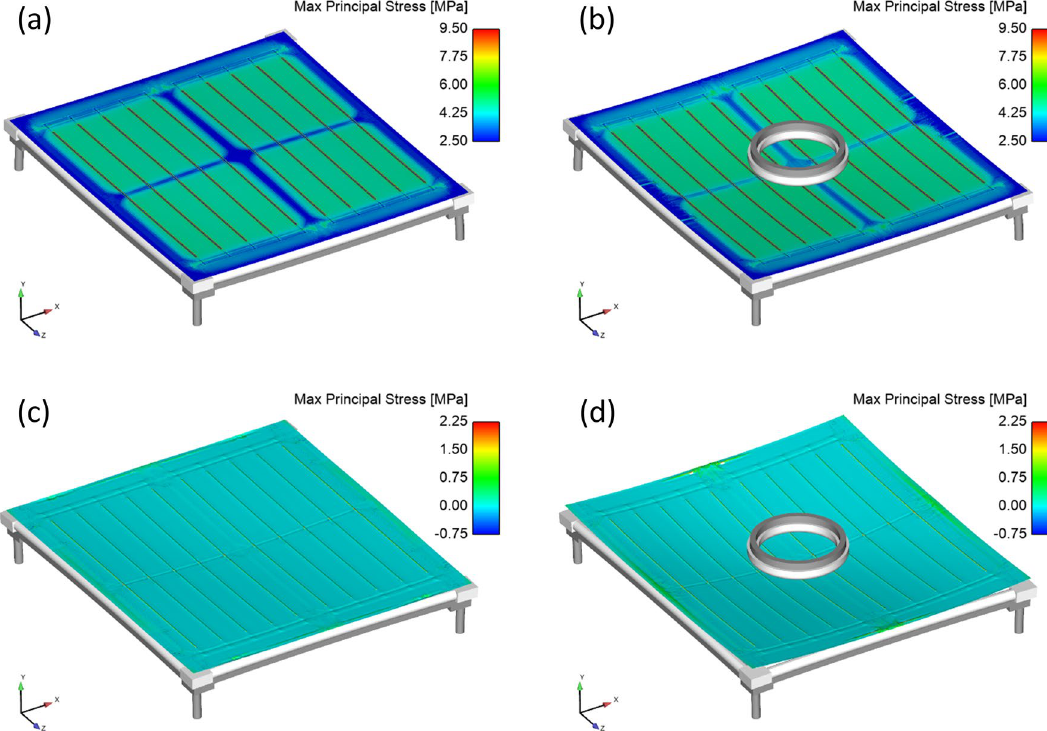
Figure 4. Simulated principal stress on backsheet for C-AST MiMos at ( a ) − 20 °C without mechanical load, ( b ) − 20 °C with mechanical load, ( c ) 90 °C without mechanical load and ( d ) 90 °C with mechanical load showing stress concentrations over cell tabbing lengths but minimal change due to mechanical loading. Displacements scaled by 10 ×. Graphics rendered using Sierra/SolidMechanics 4.56, https ://www.sandi a.gov/ASC/integ rated _codes